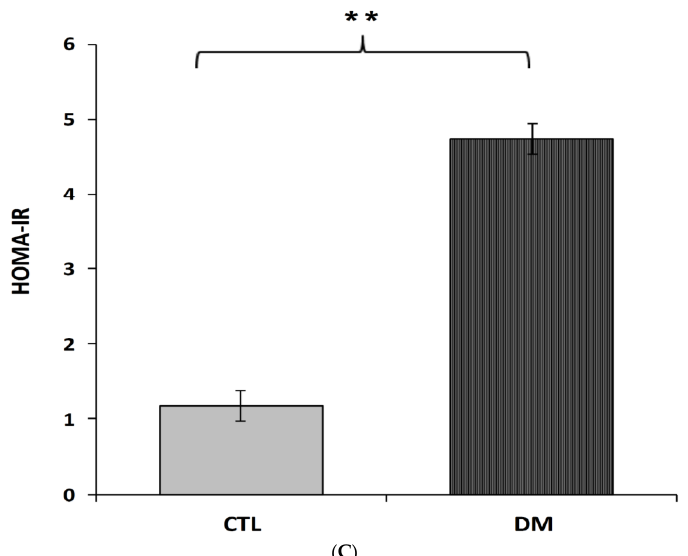
Figure 3. Level of glucose ( A ), insulin ( B ), HOMA-IR index ( C ) in the blood serum of diabetic mice. Data are expressed as mean ± SEM ( n = 6). CTL: Control mice, DM: Diabetic mice. ** p < 0.01 vs. control.